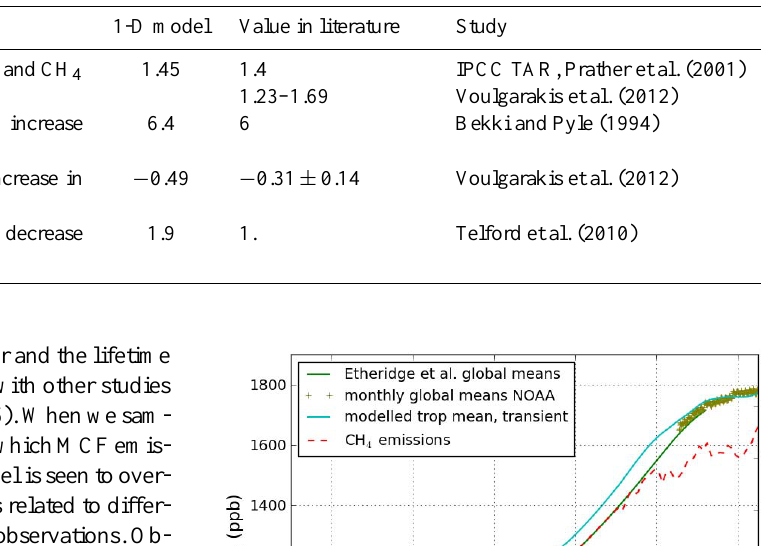
Table 5. Sensitivities and feedback factors of our column chemistry model and comparison to literature.